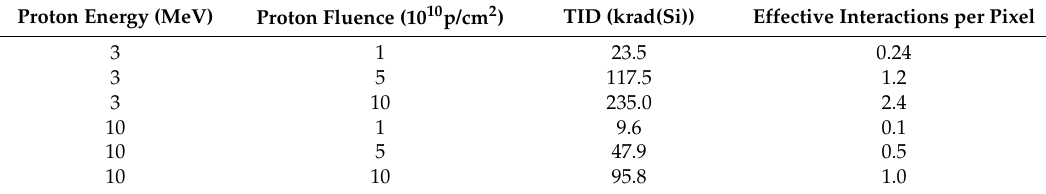
Table 2. Calculated